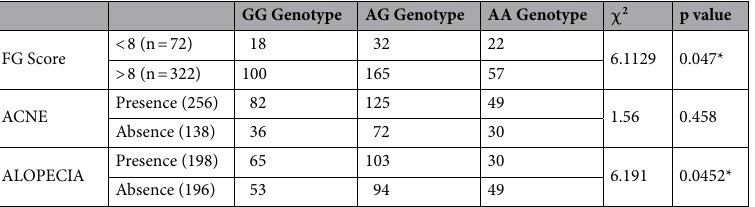
Table 5. Association of CYP19 gene polymorphism with various hyperandrogenic parameters in PCOS women. *Significant p value <